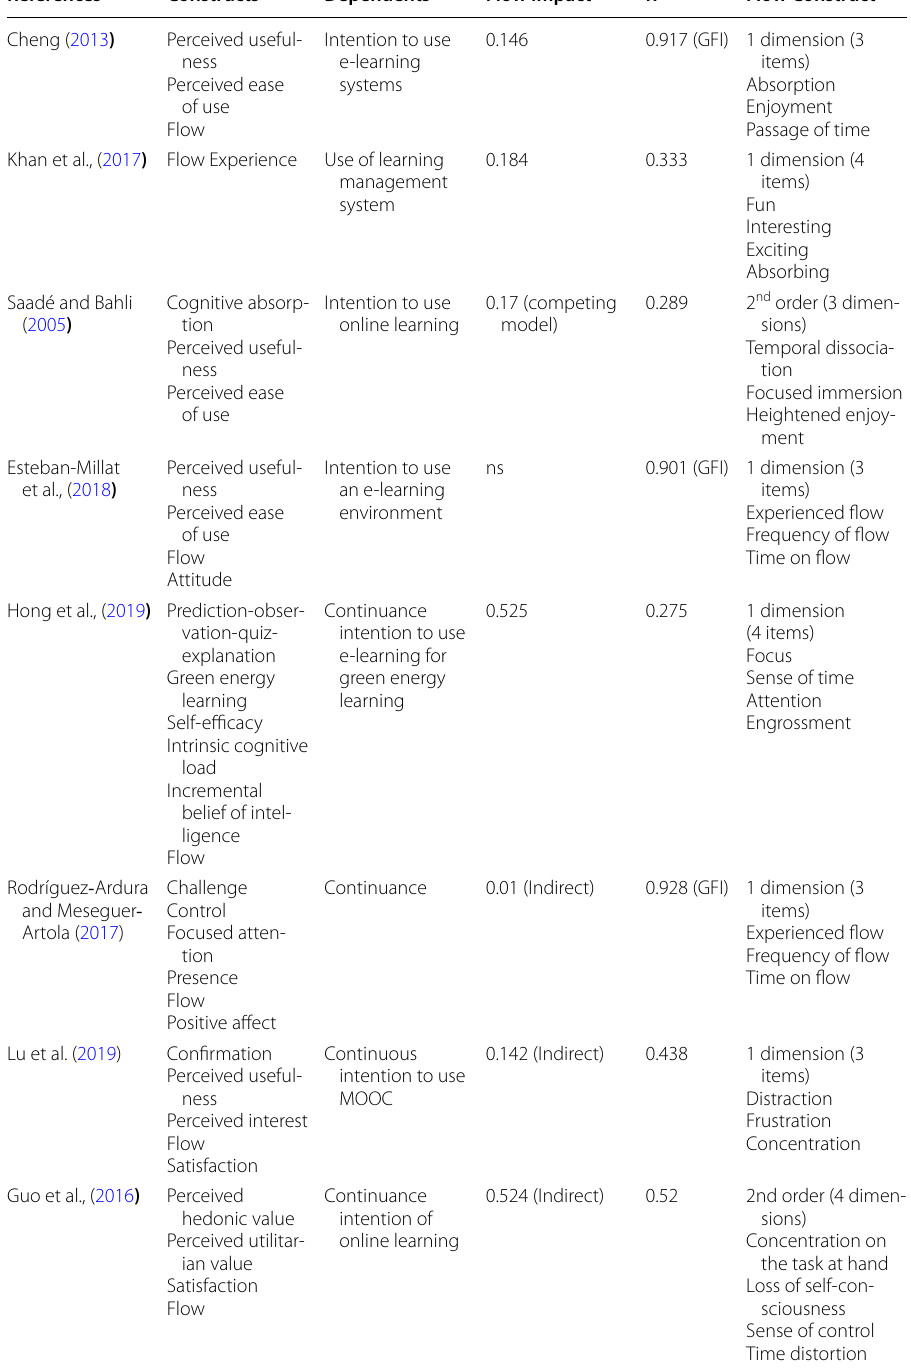
Table 1 A survey of flow constructs and its impact measured by path strength and R 2 on continued intention in